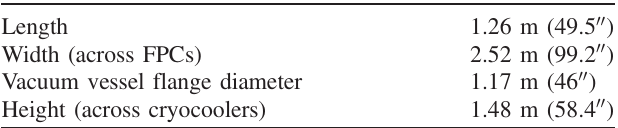
TABLE IV. Overall cryomodule dimensions.